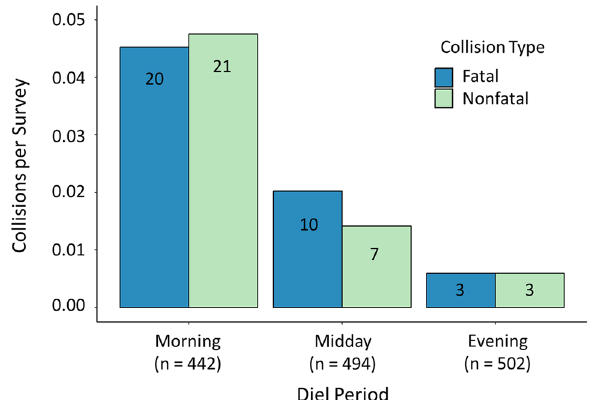
Figure 1. Number of bird-window collisions relative to time of day. Number of fatal and nonfatal bird collisions per survey during three different diel periods in Stillwater, Oklahoma, USA, 2015–2016. Total collision counts are shown in bars, and n is the number of surveys for each